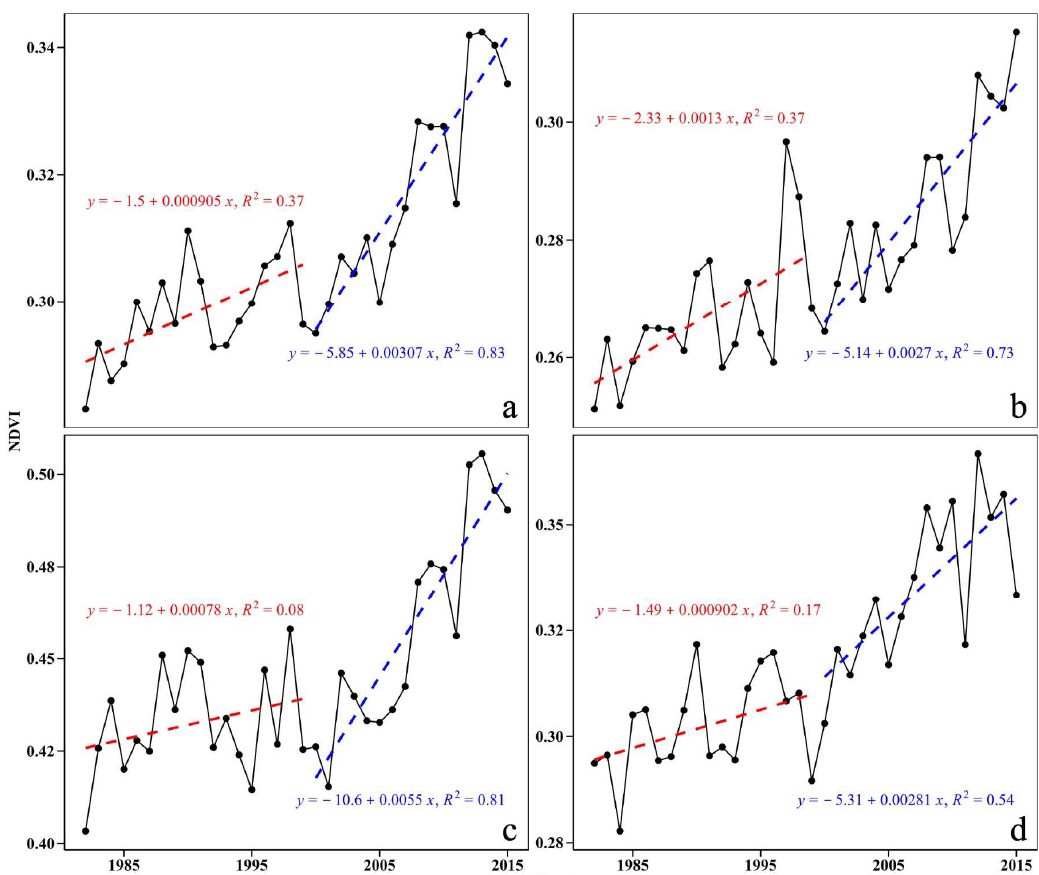
Figure 3. Interannual variations in NDVI of ( a ) interannual scale, ( b ) spring, ( c ) summer, and ( d ) autumn in the LP from 1982 to 2015. The lines in red and blue represent the NDVI trend before the BP (BBP, 1982–1999) and after the BP (ABP, 2000–2015), respectively.